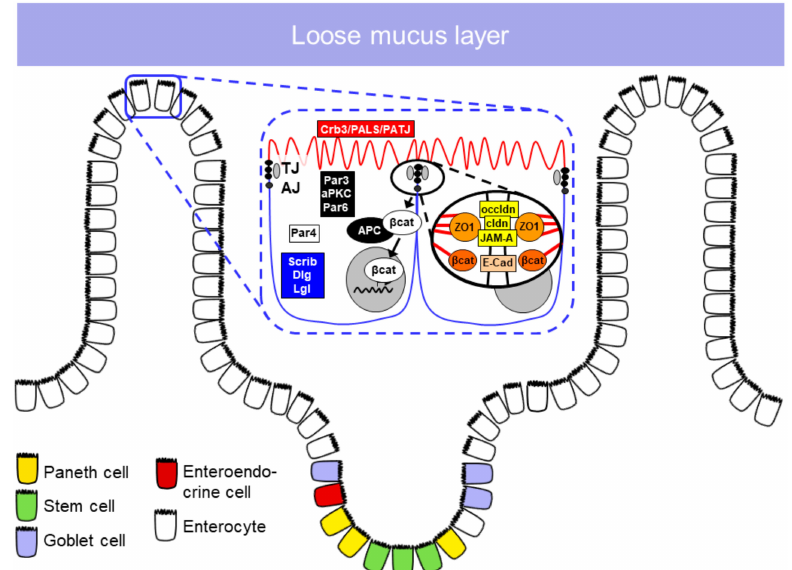
Figure 1. Mucus and epithelial barrier of the mucosa. TJ, tight junction; AJ, adherens junction; Crb3, crumbs3; PALS-1, protein associated with Lin7; PATJ, Pals1-associated tight junction protein; Par, Partition defective; aPKC, atypical protein kinase C; Scrib, scribble; Dlg, Discs large homolog-1; Lgl, Lethal giant larvae protein; β cat, β -catenin; APC, adenomatous polyposis coli protein; ZO1, zonula occludens protein-1; occldn, occludin; cldn, claudin; JAM-A, junctional adhesion molecule-A; E-Cad,